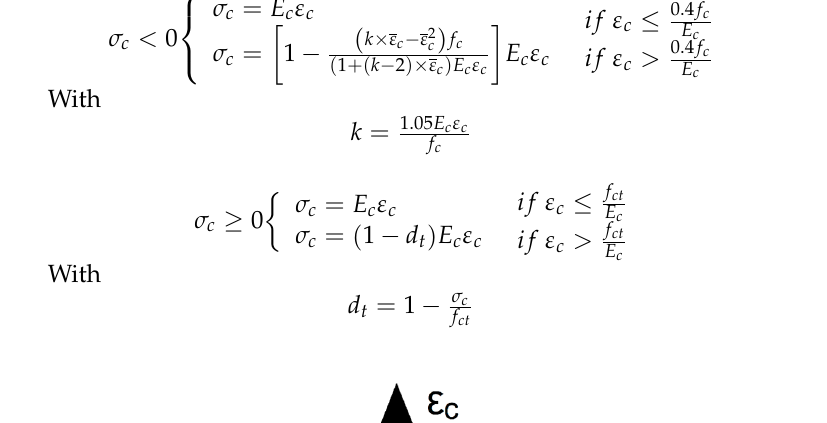
6 of 25 Figure 4. Stress-strain curves for ( a ) concrete and ( b ) steel, both adapted from [21].